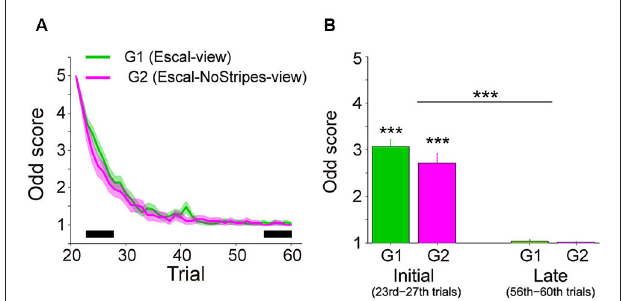
FIGURE 2 | Subjective scores of odd sensation over the trials in the Escal-view and the NoStripes-view conditions (A2 and A3 in Figure 1) . (A) Trial histories of odd sensation scores of G1 (Group 1: Escal-view, colored by green) and G2 (Group 2: Escal-NoStripes-view, colored by pink). Solid line: mean, Colored area: SE. (B) Comparison between mean scores during initial phase (23rd–27th) and late phase (56–60th), indicated by the thick horizontal bar in panel A , in both groups. Asterisks above the bar denote statistical significance of the mean from one by a t -test, and asterisks above the horizontal line denote statistical significance of the trial-phase (initial/late) factor, obtained by ANOVA. The error bar denotes SE and “***” denotes p <